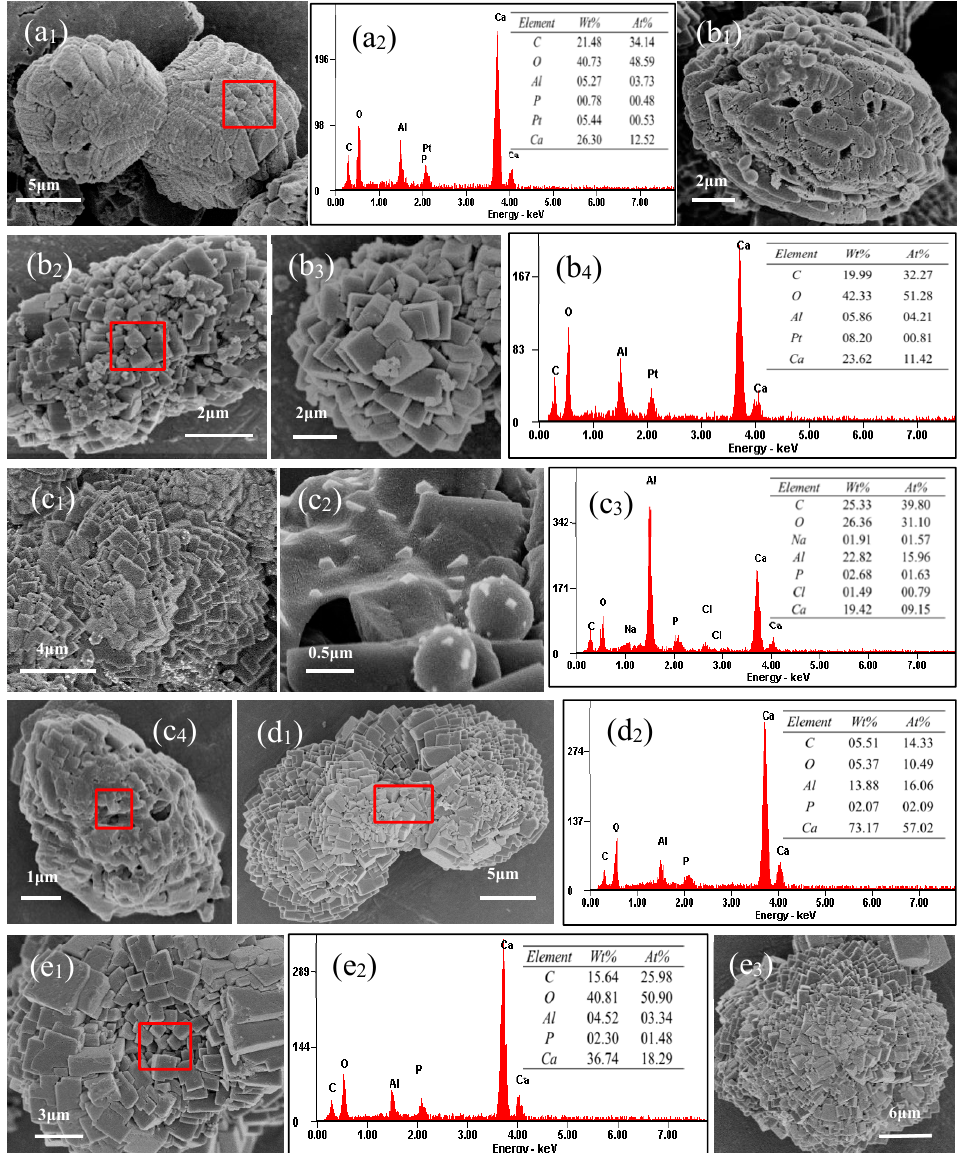
Figure 6. SEM and EDS analyses of minerals in the MgSO 4 medium at different Mg/Ca ratios. ( a1 , a2 ) Mg/Ca ratio of 0; ( b1 – b4 ) Mg/Ca ratio of 2; ( c1 – c4 ) Mg/Ca ratio of 4; ( d1 , d2 ) Mg/Ca ratio of 6; ( e1 – e3 ) Mg/Ca ratio of 8.